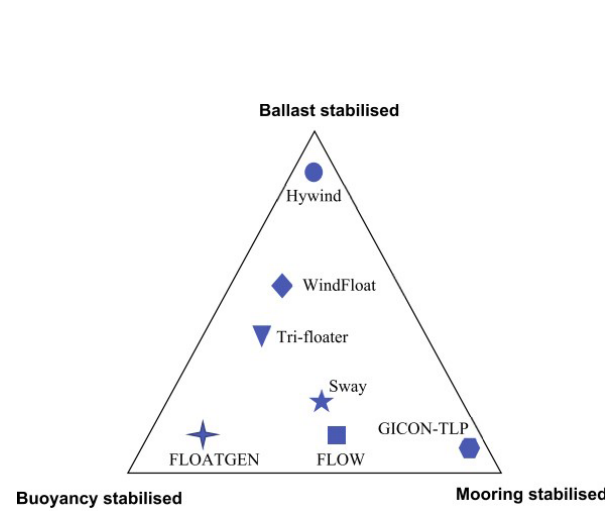
Figure 2. Stability triangle for floating structures (Jiang,